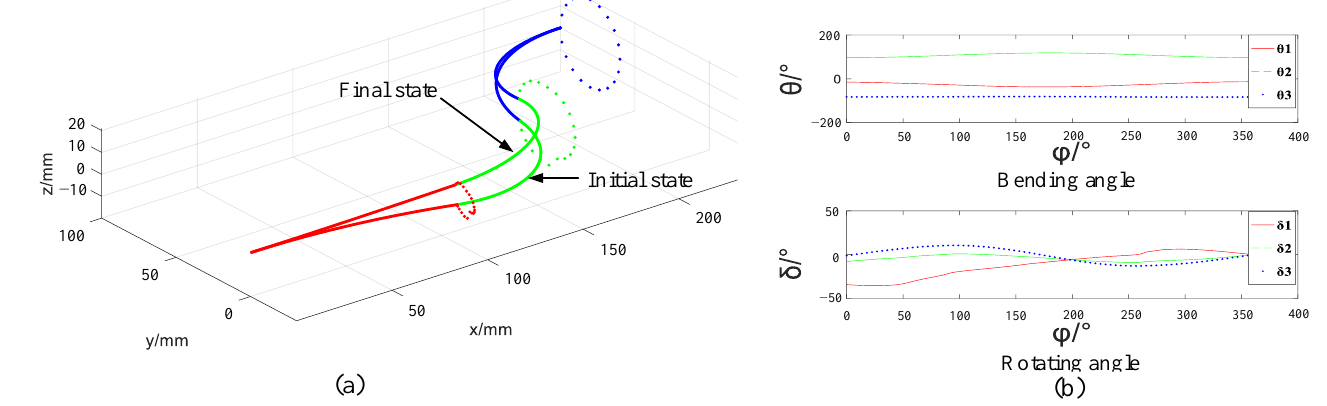
Figure 12. Circle trajectory following simulation of the single arm. ( a ) Circle trajectory following, ( b ) Angle change of the manipulator.